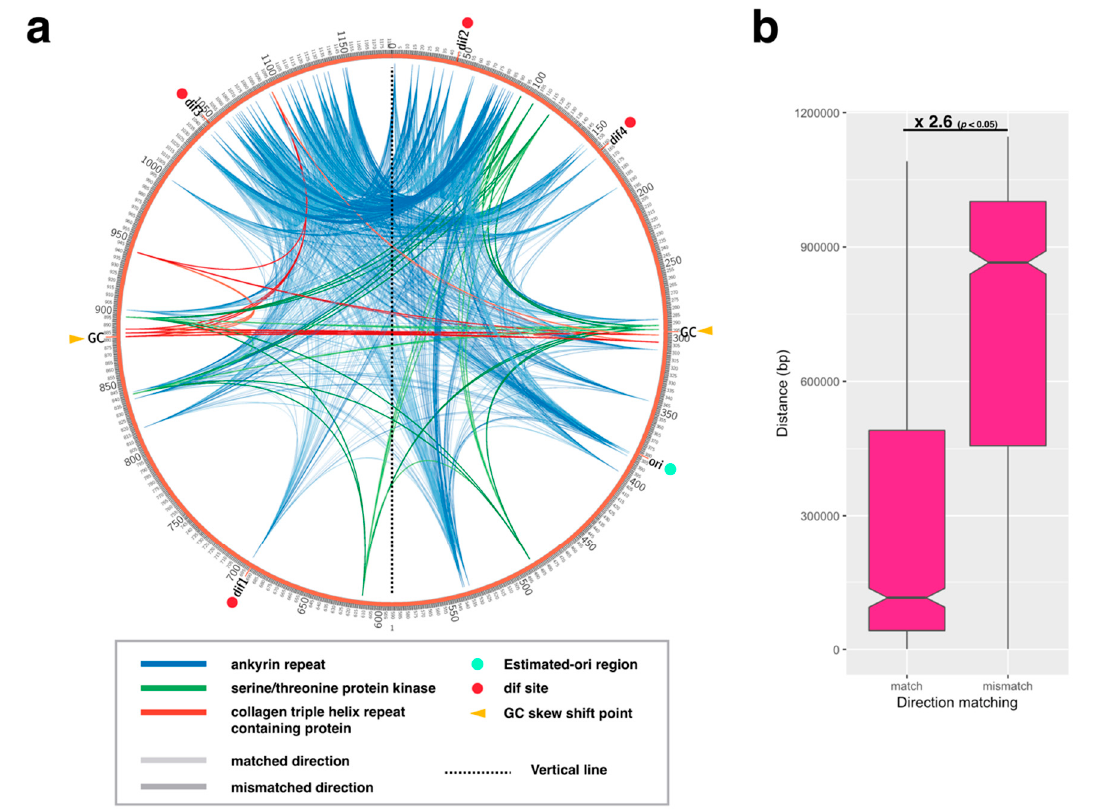
Figure 3. Paralogous gene localization found at the GC skew shift point. ( a ) The three genes found on the GC skew shift point were plotted (ankyrin repeat, serine/threonine kinase, and collagen triple helix repeat containing protein). Four dif sites ( dif 1-4) were described previously (see text). Each of the three genes were separately categorized as matching or mismatching the coding sequence (CDS) direction on the Acanthamoeba polyphaga mimivirus (APMV) genome (AY653733.1) with shades of colors (light: matched direction; dark: mismatched direction). ( b ) Distances between each pair of CDSs in each of the three genes were plotted by the CDS direction matching patterns on the APMV genome (“match” or “mismatch”). Labels above the box plots indicate the fold change between the two values with the resulting p -value from KS-tests.